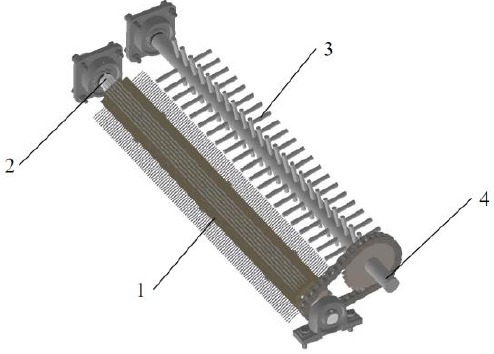
Figure 5. 1. Brush strip; 2. drive shaft; 3. spikes; and 4. unloading the cotton shaft. A hydraulic motor drives the cotton unloading and cotton-picking mechanisms to rotate in opposing directions via chain drive and reversing gear during operation. When roller, the force of the brush roller is sufficient to overcome the resistance of the serrated tooth and brush the cotton off the serrated tooth; this is because the friction coef- ficient between the brush and the cotton fiber is more significant than that between the cotton fiber and the serrated tooth [21].